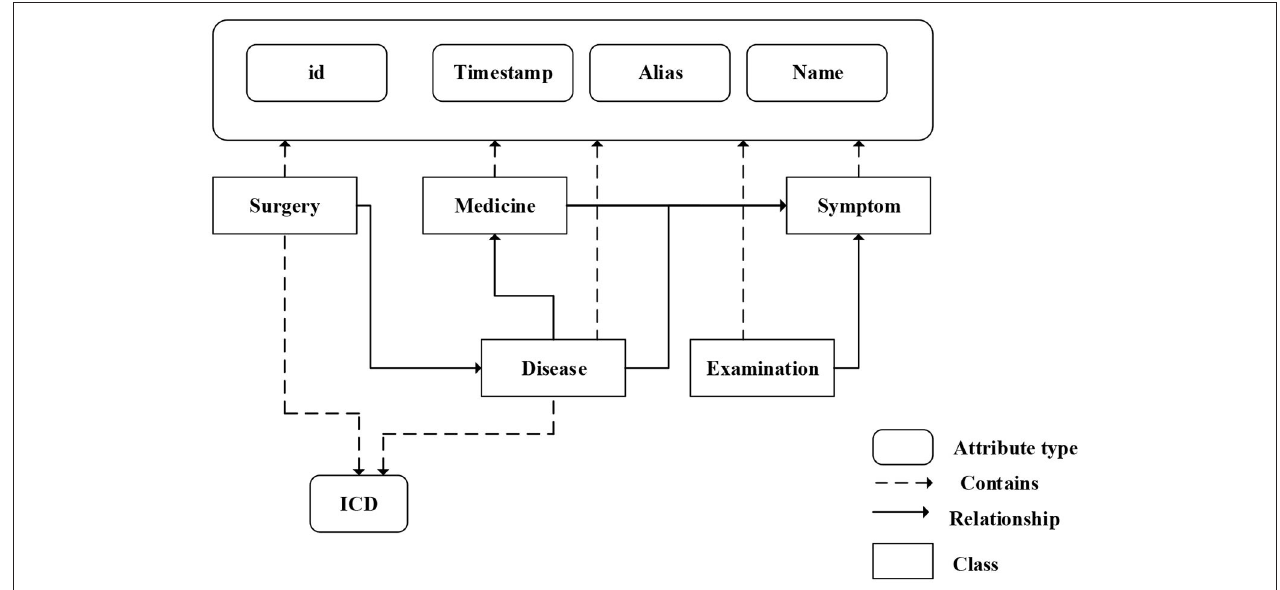
FIGURE 2 | The ontology of medical knowledge